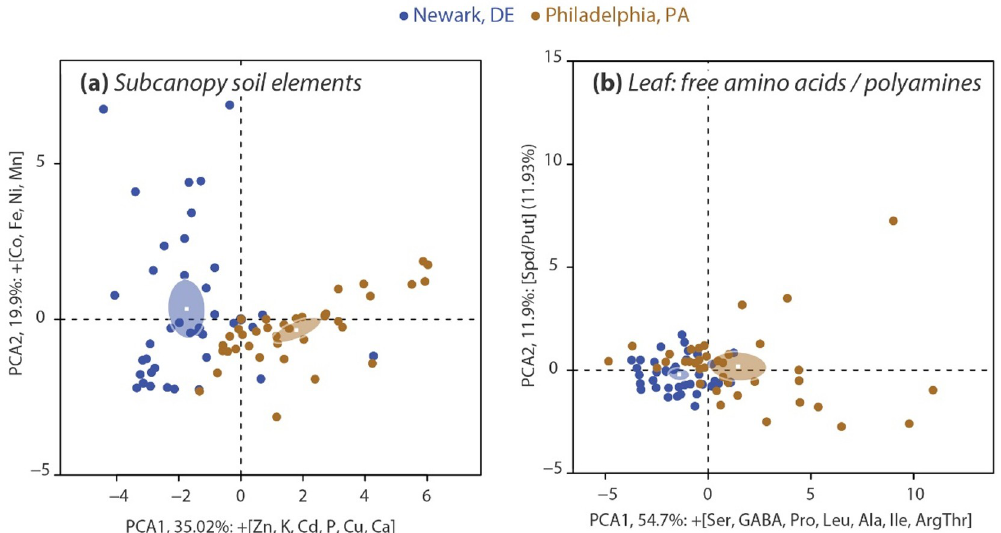
Fig 3. Principal component analysis for total soil elements (a) in the top 10 cm of soil and foliar free amino acids and polyamines (b) from 77 mature, native red maple trees in ten urban deciduous forests in Newark, DE and Philadelphia. PCA components that most strongly loaded on each axis are listed next to their respective axis in order of strongest to weakest. (+/-) represents values that indicate variables are positive/negative and strongly loaded on the axis. Ellipses represent group